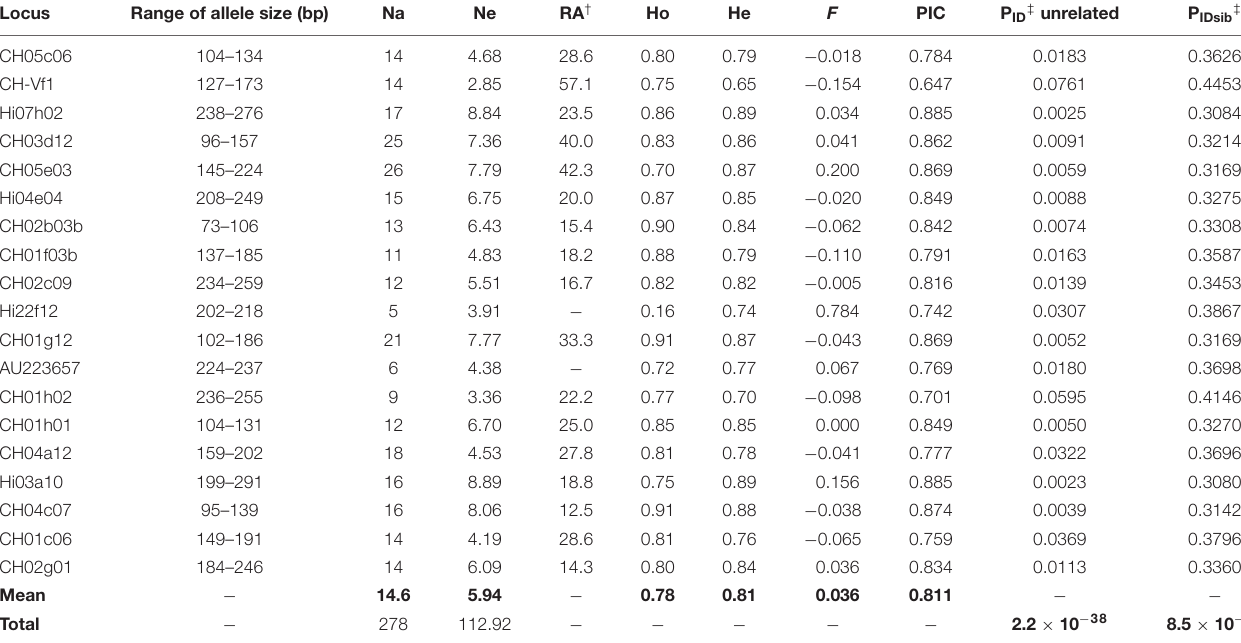
TABLE 3 | Genetic diversity in terms of range of allele size (bp), number of allele (Na), effective number of alleles (Ne), percentage of rarity (RA), observed (Ho) and expected (He) heterozygosity, inbreeding coefficient (F), polymorphic information content (PIC) and probability of identity (P ID and P IDsib ) of all 175 accessions of apple germplasm